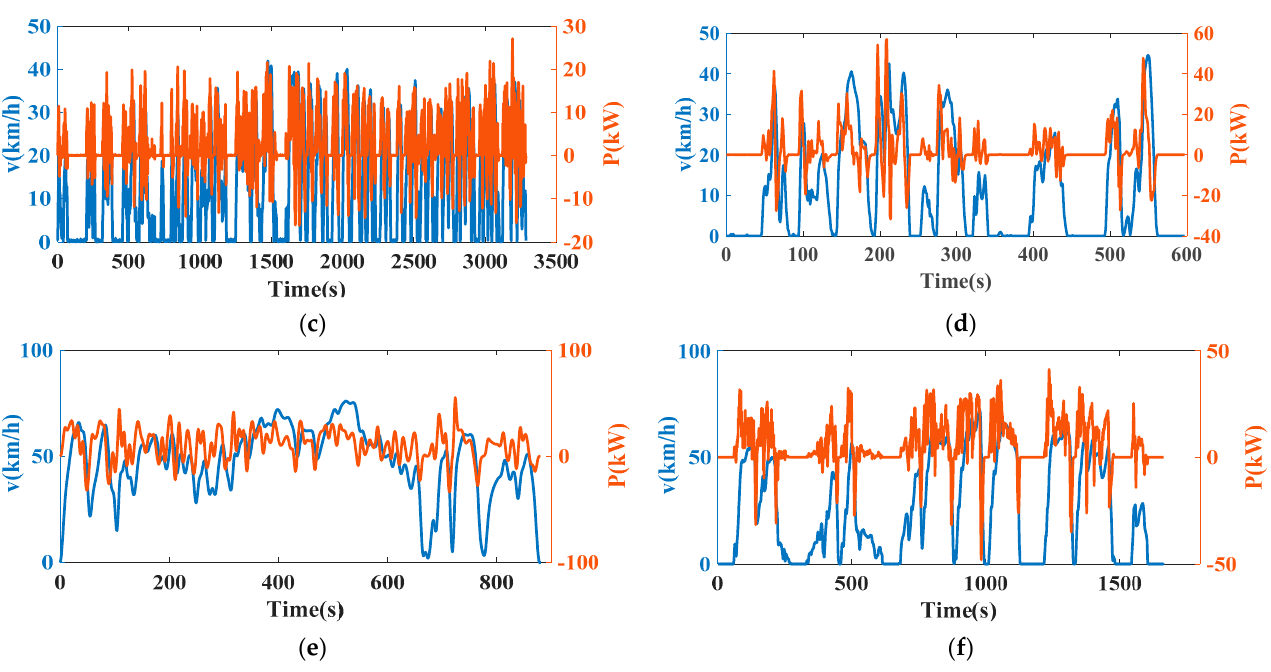
Figure 2. Velocity and power curves for six standard driving cycles. ( a ) HL07; ( b ) HWFET; ( c ) UKBUS6; ( d ) NYCC; ( e ) INDIA-HWY-SAMPLE; ( f ) WVUSUB.